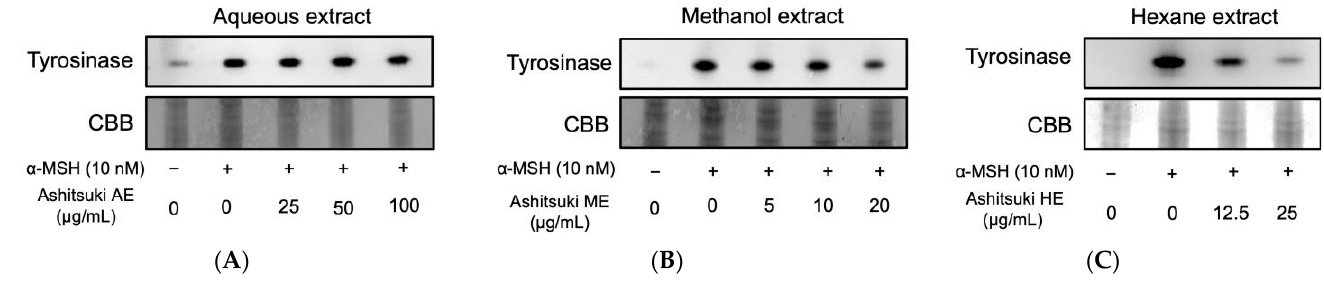
Figure 7. Effect of N. verrucosum aqueous ( A ), methanol ( B ), and hexane ( C ) extracts on intracellular active tyrosinase. B16F1 melanoma cells were treated with N. verrucosum extracts for 3 d in the presence of 10 nM α -MSH. After treatment, cell lysates were subjected to SDS-PAGE and DOPA staining was performed.